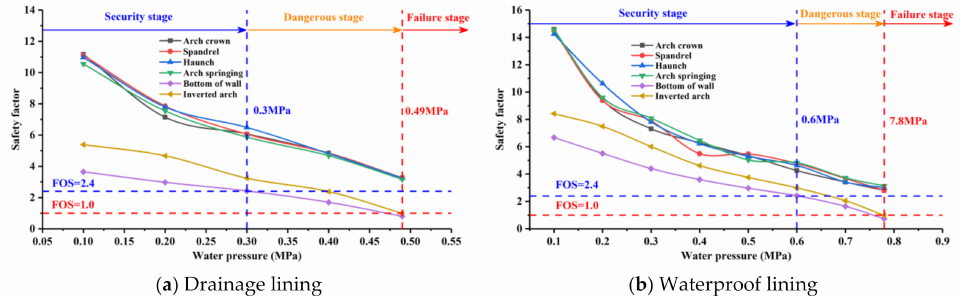
Figure 11. Relationship between the safety factor and the water